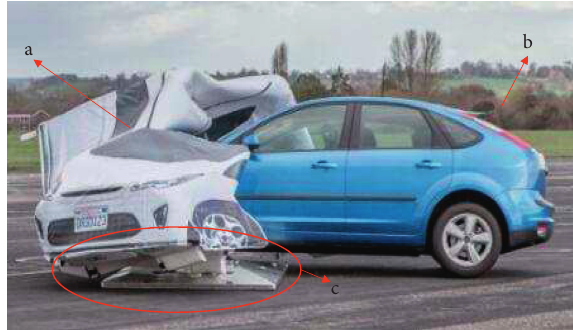
Figure 2: Application scenarios of testing platform vehicle: (a) GVT, (b) VUT, and (c) testing platform